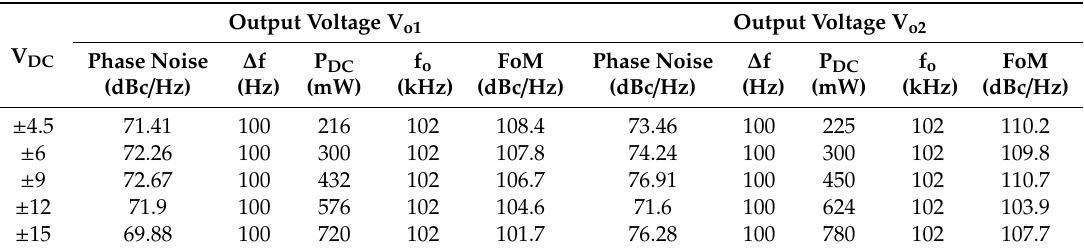
Table 5. Phase noise performance measured at di ff erent supply